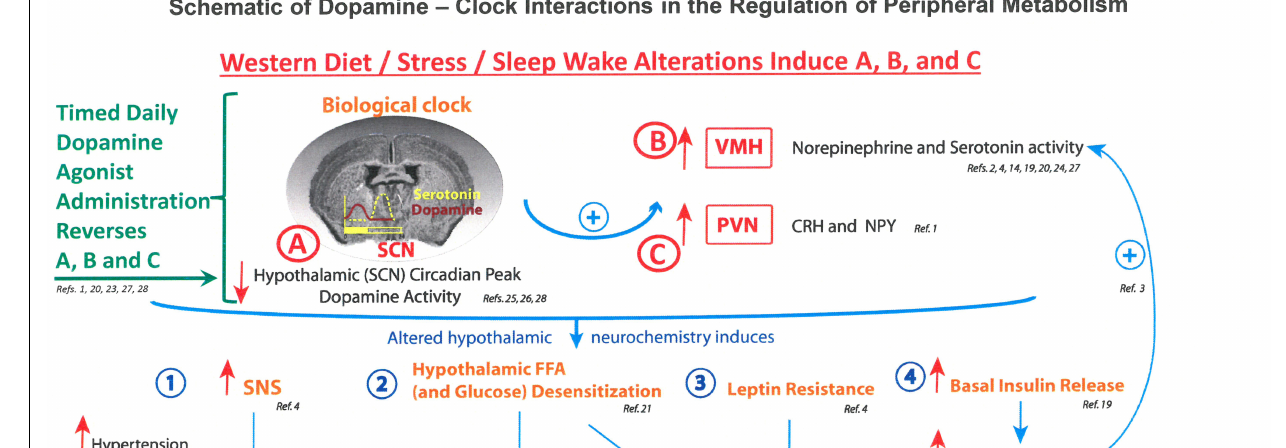
Frontiers in Neuroscience |